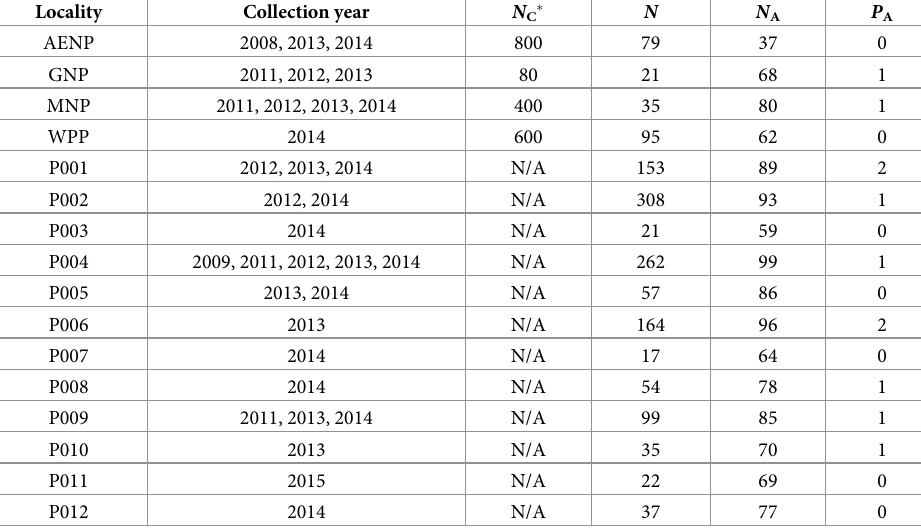
Table 1. Sample information and selected summary statistics of Cape buffalo from the 16 localities included in this